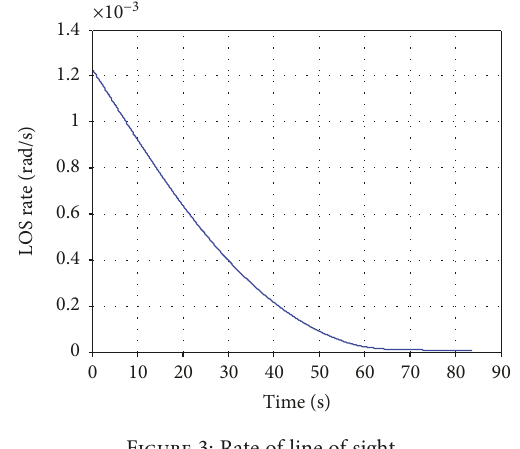
Figure 3: Rate of line of sight.